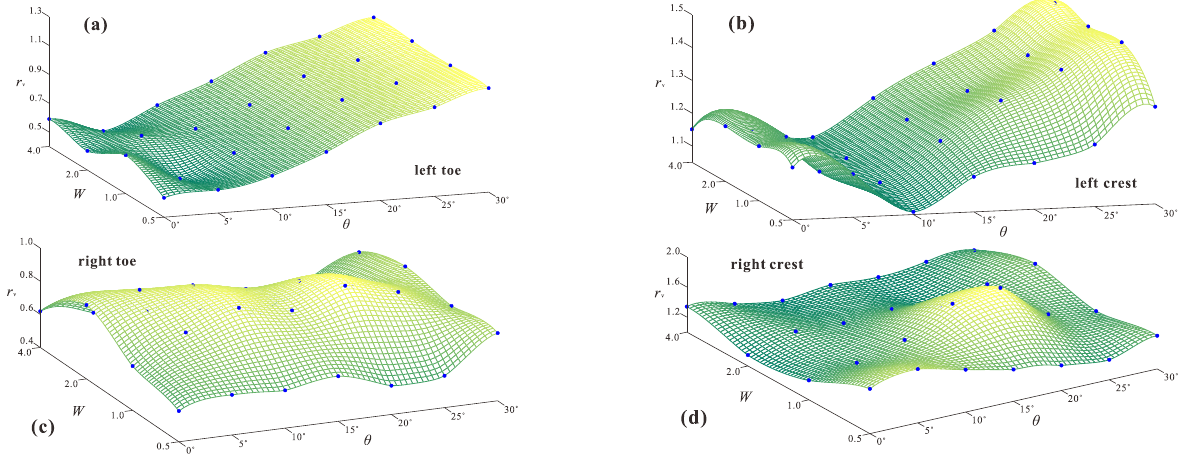
Figure 23. Variations of the vertical amplification ratios ( r v ) of PGA at the observation points (( a ) left toe, ( b ) left crest, ( c ) right toe and ( d ) right crest) with varied angles of wave incidence at different slope widths.